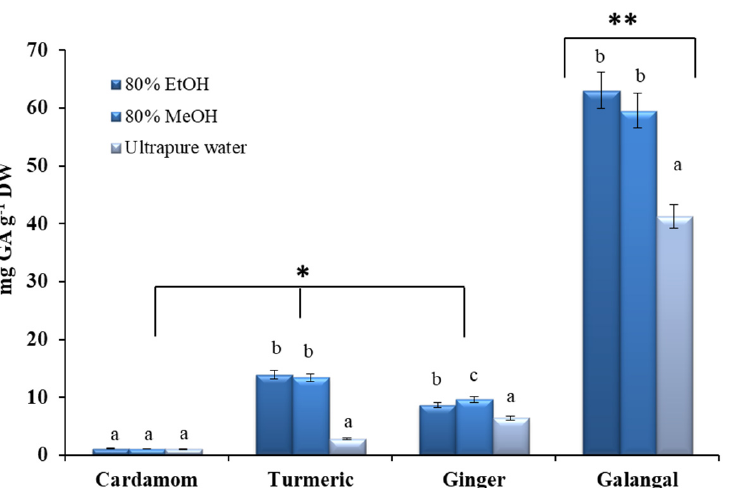
Figure 2. Total phenolic content (TPC) for crude extracts of the selected Zingiberaceae species, expressed as mg of gallic acid equivalents per gram of dry weight (mg GA g − 1 DW). All measurements were performed in duplicate. For comparison of the mean values, one-way ANOVA followed by S-N-K post hoc was used. Different superscript letters indicate statistical differences in the extraction efficiency of the tested solvents ( p < 0.05), while asterisks indicate statistical differences in TPC content between different plants ( p < 0.05).